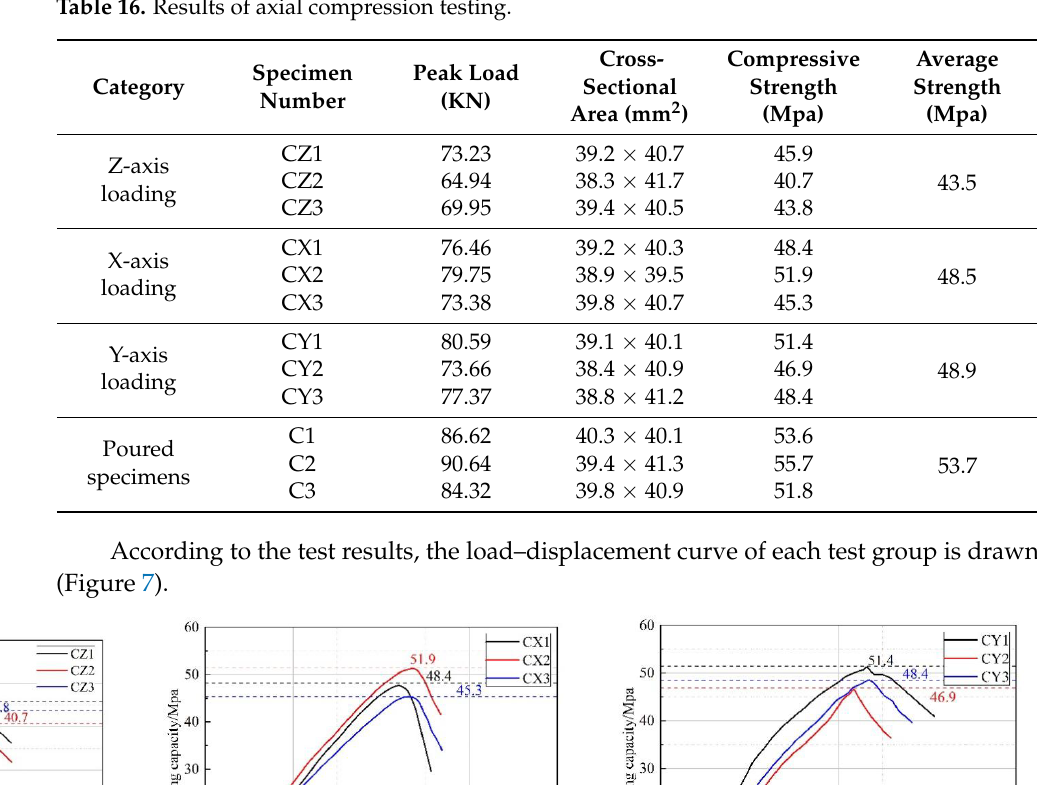
Table 16. Results of axial compression testing.